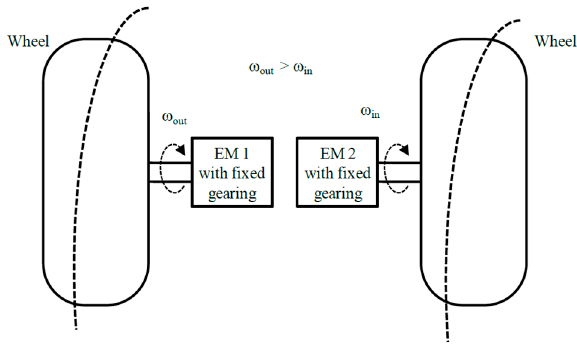
Figure 14. Dual-motor drive with fixed gear system.